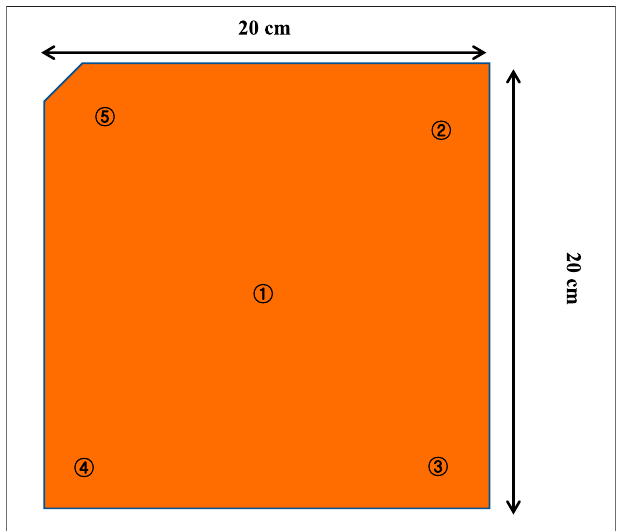
FIGURE 4 | Spectroscopic ellipsometry measurements